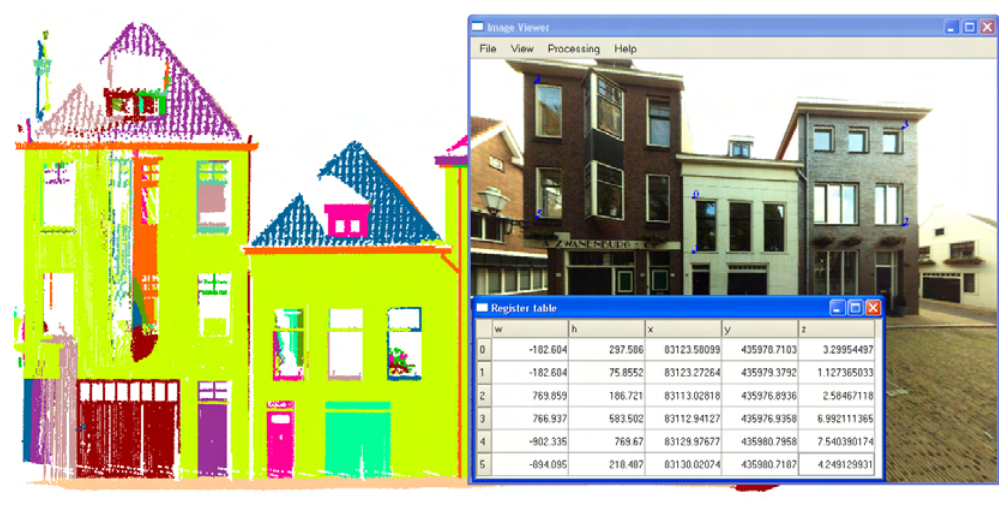
Figure 4. Selecting tie points for spatial